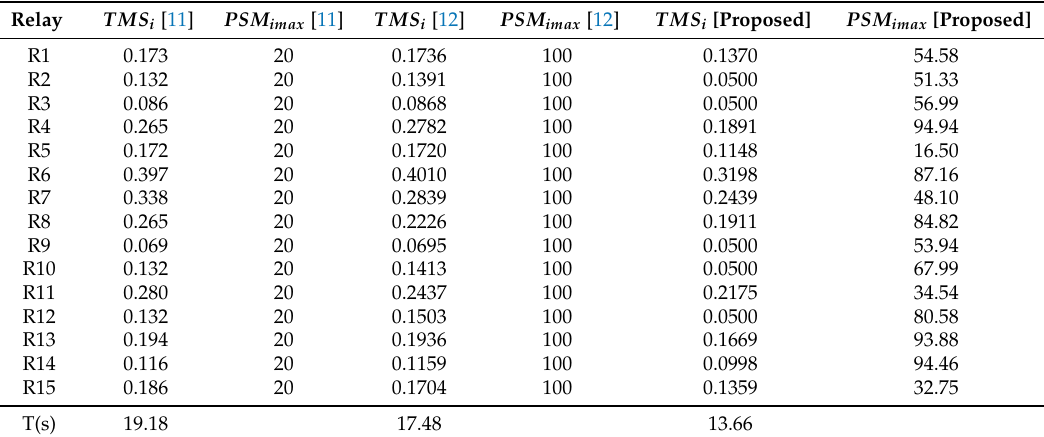
Table 5. Coordination parameters for OM2.